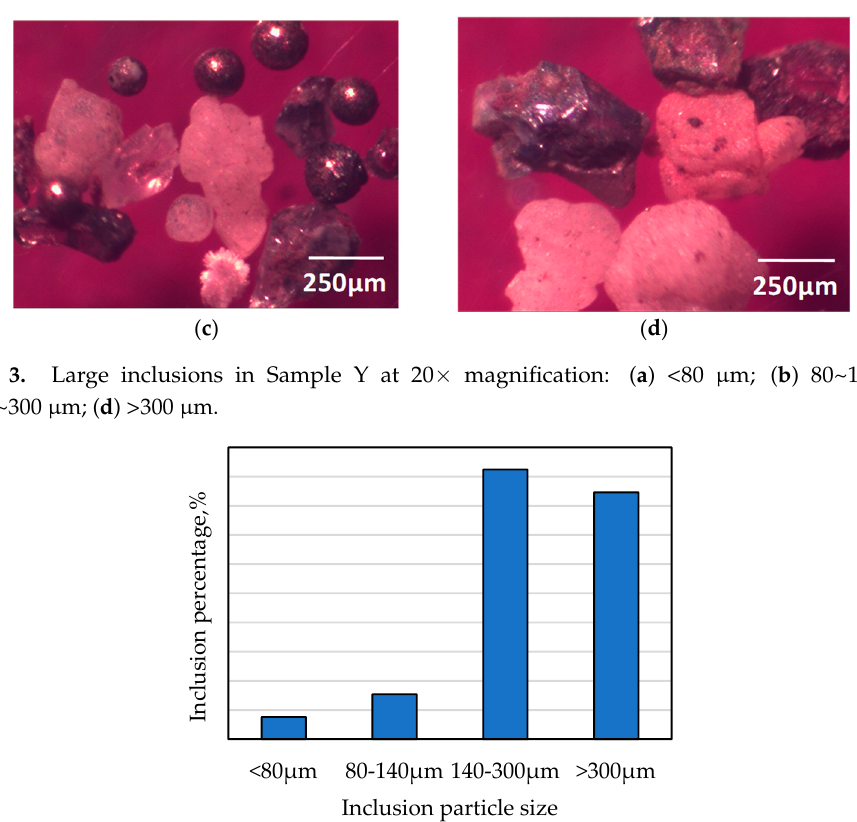
Figure 4. Size distribution of inclusion particles in Sample Y.